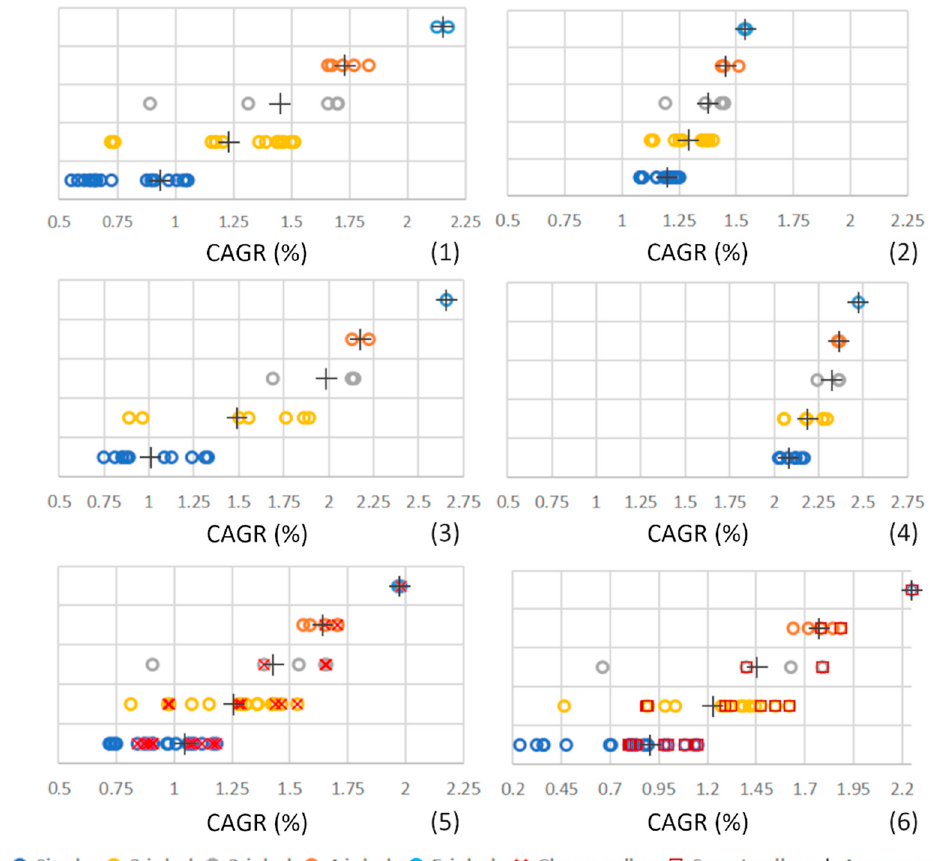
Figure 8. CAGR (Compound Annual Growth Rate) % in the different scenarios ( 1 – 6 ), the CAGR are real (i.e., would be higher if adjusted for inflation), and assume a case in which there is no growth in the price of electricity, a chart assuming a 2% linear increase in the price of electricity from Scenario 4 is in the Appendix